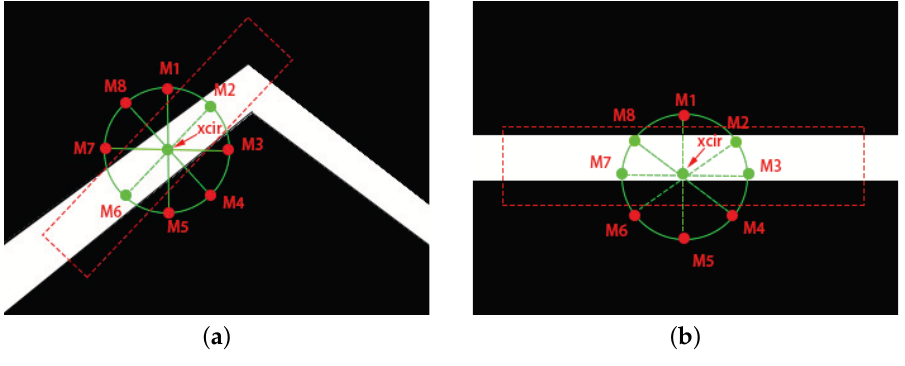
Figure 4. ( a , b ) are examples of x cir inside the narrow